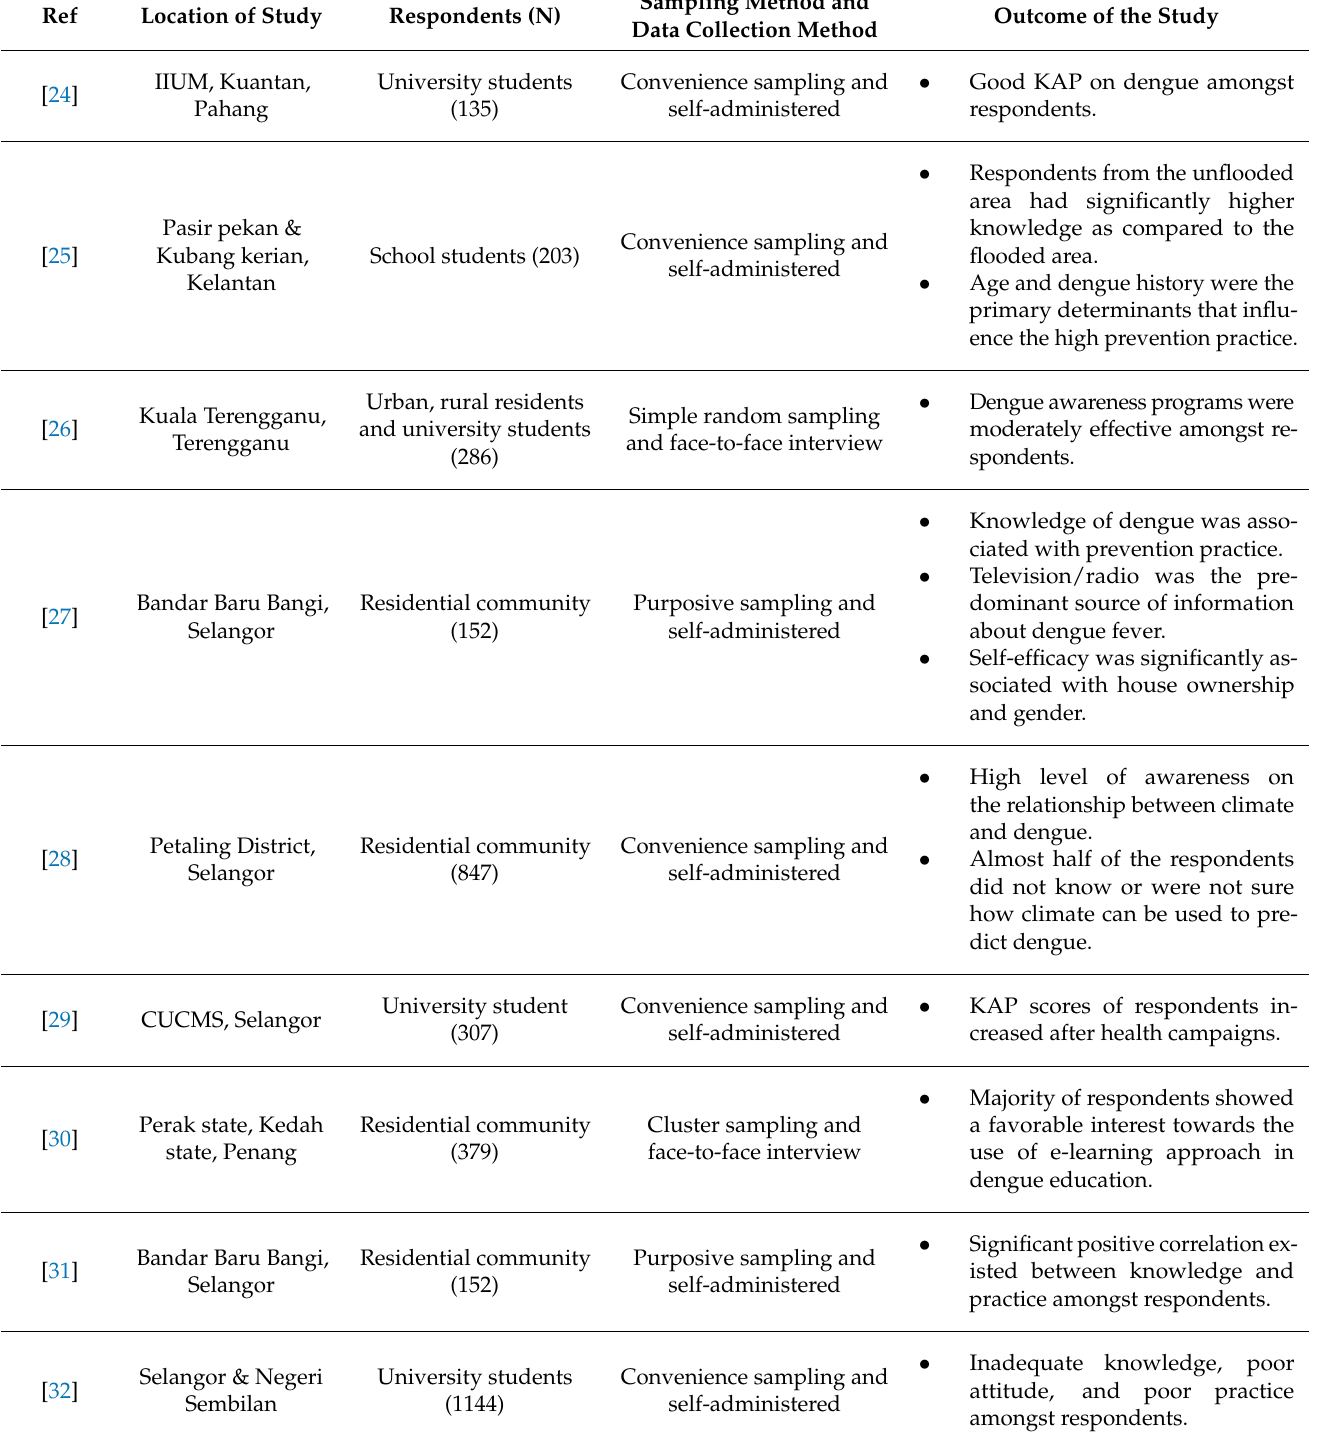
Table 1. List of questionnaire-based dengue fever studies in Malaysia (April 2000–April